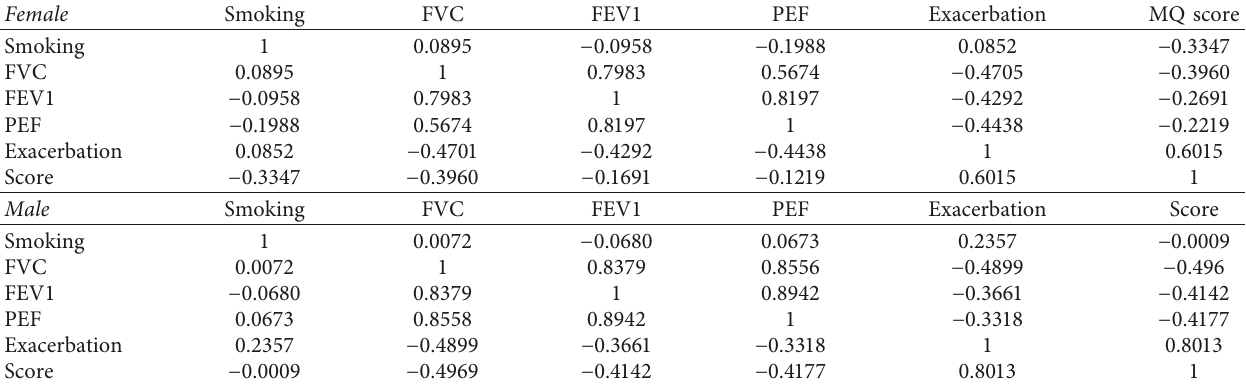
Table 2: Correlation between the parameters of spirometry, smoking, exacerbations, and the modified questionnaire score.